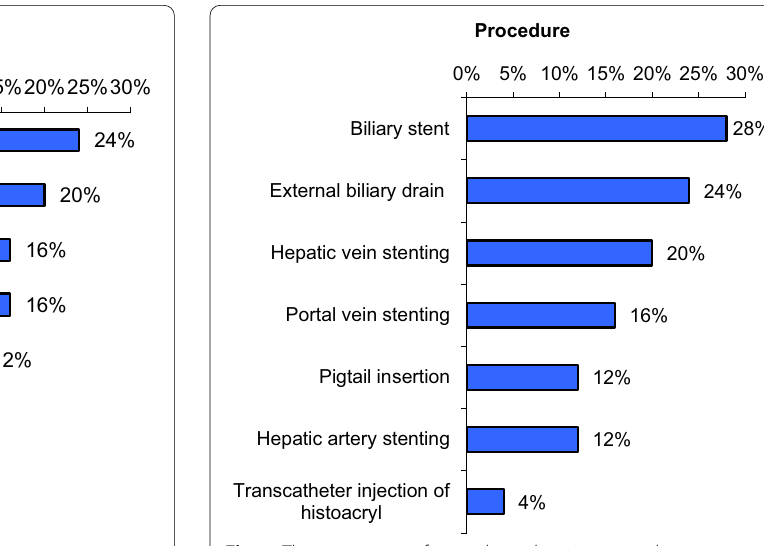
Fig. 5 The percentage of procedures done in our study